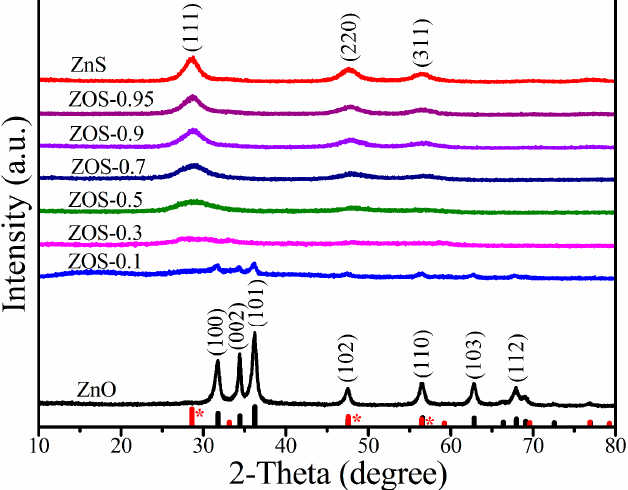
Figure 1. XRD patterns of ZnO, ZnS, and ZnO/ZnS photocatalysts.